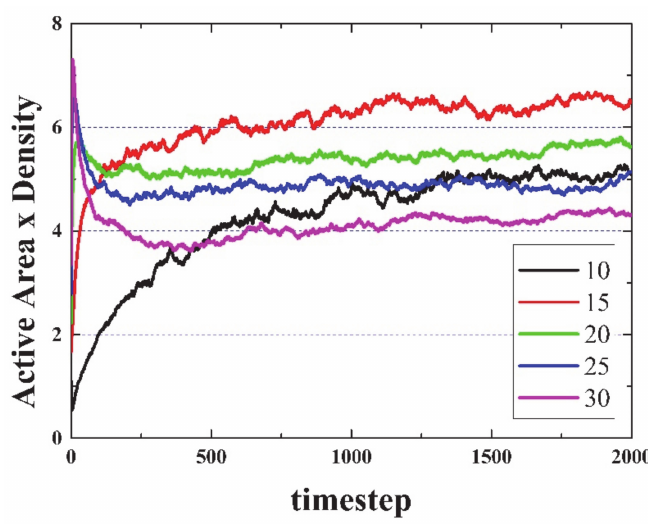
Figure 3. (Color online) Density x Active area vs. time for five different initial densities, from 10 to 30%, as labeled.